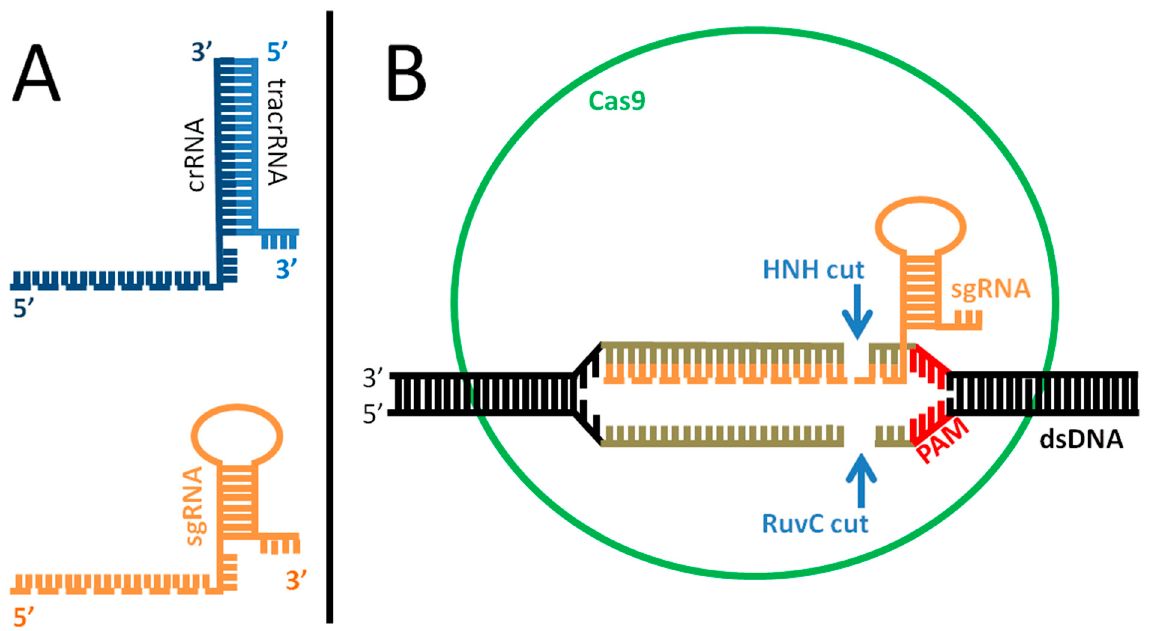
Figure 2. Mechanism of action of the Cas complex. ( A ): difference between natural (top) and engineered (bottom) guide RNA (gRNA). The natural system is composed of two parts, crRNA (dark blue) and tracrRNA (light blue), which are paired and drive Cas9 to target the invading viral DNA. The portion of the crRNA recognizing the target is indicated as a dotted line. In the engineered form, the synthetic, single guide RNA (sgRNA) is one molecule that mimics the shape of its natural counterpart, including the target recognition site (dotted line). ( B ): for genome editing, the sgRNA (orange) is incorporated inside the Cas9 protein (green) and recognizes the double-stranded target DNA (black-grey) promoting the pairing. In case of homology (pairing sequence length: 21–72 bp, indicated in gray) and in the presence of a PAM sequence (red) on the target DNA, the Cas protein cuts the DNA 3 bp upstream of PAM, causing a double strand break, thus inactivating target gene function. The repair of the target chromosome damage in eukaryotic cells usually employs the error prone NHEJ (non-homologous end joining) mechanism; however, in presence of an exogenous DNA template (injected with the Cas complex and sgRNA), the cell may fix the break through homologous-driven repair, thus introducing the sequence of interest inside the genome.